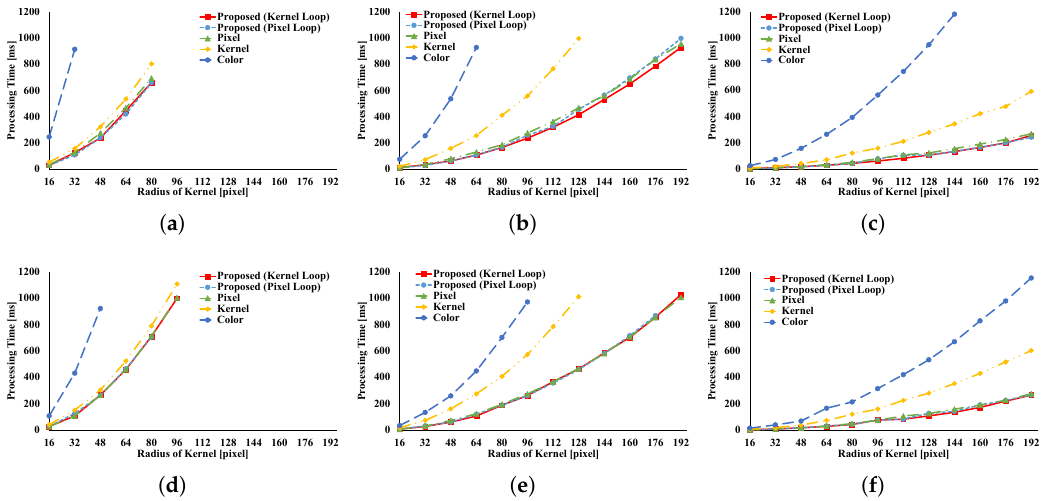
Figure 8. Processing time for Gaussian range filtering (GRF) with respect to the kernel radius of FIR filtering. ( a ) Full sample in weight computation; ( b ) 1/4 subsample in weight computation; ( c ) 1/16 subsample in weight computation; ( d ) Full sample in LUT; ( e ) 1/4 subsample in LUT; ( f ) 1/16 subsample in LUT. Note that arbitrary kernel loop unrolling is used instead of kernel loop unrolling under kernel-subsampling conditions.